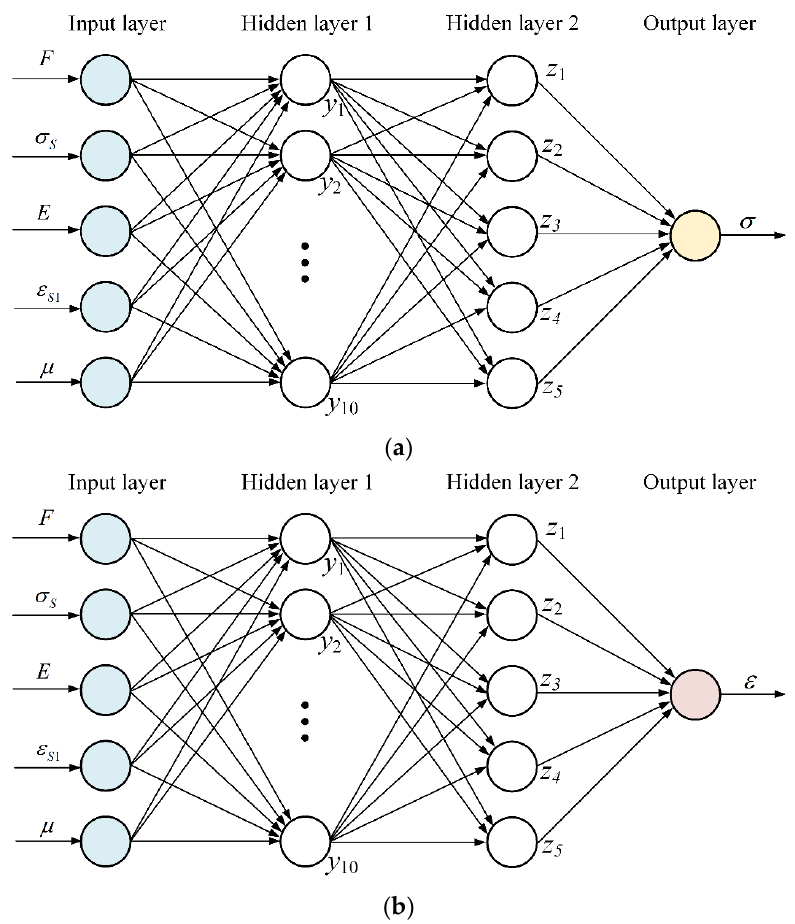
Figure 8. ANN structure diagram: ( a ) stress model structure diagram; ( b ) strain model structure diagram.